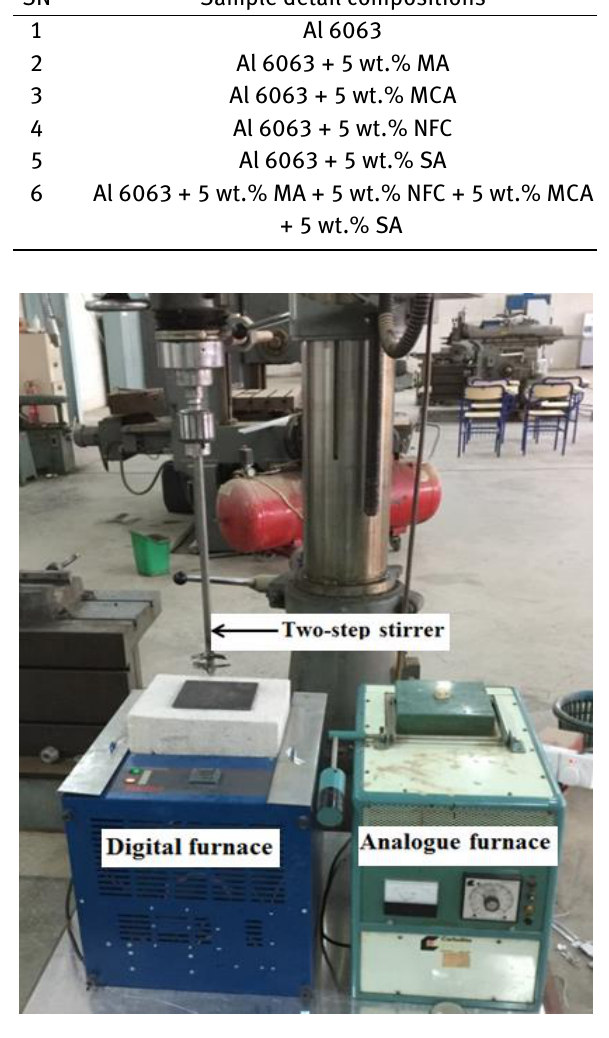
bility with the Aluminum 6063 alloy for 30 minutes. The Aluminum 6063 ingots were charged into a digital electric furnace and heated to a temperature of 750 ± 30 ∘ C. The pre- heated reinforced particles were added at this temperature and stirring of the slurry was performed by using modi- fied two-step mechanical stirrer and having three blades at each step. The stirring operation speed and time were performed 360 rpm and 10 minutes respectively to help improve the distribution of the reinforced particles in the molten aluminum 6063 alloys. Finally, the molten com- posite slurry was poured into the steel mold to solidify. A schematic view of the stir casting set up shown in Figure